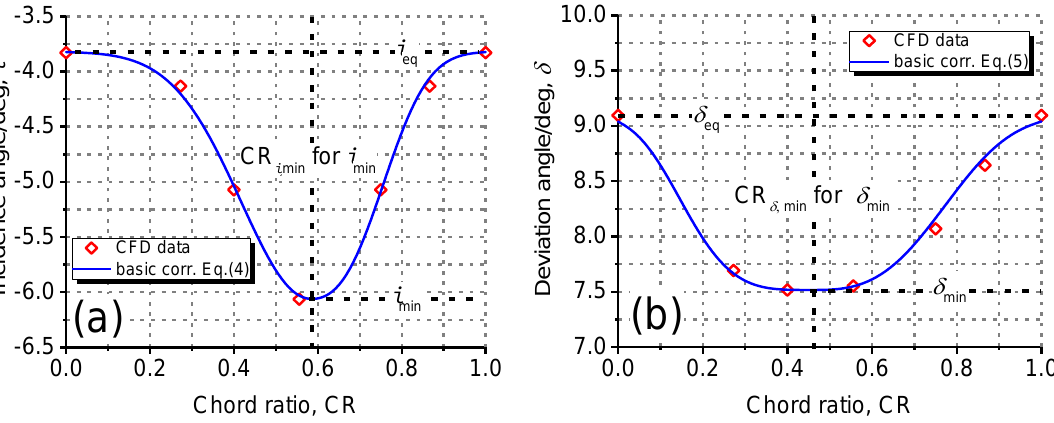
Figure 8. Variation profiles of reference minimum-loss ( a ) incidence and ( b ) deviation angles with CR. ES 1.78, camber angle 38.3°, inlet metal angle 63.0°.